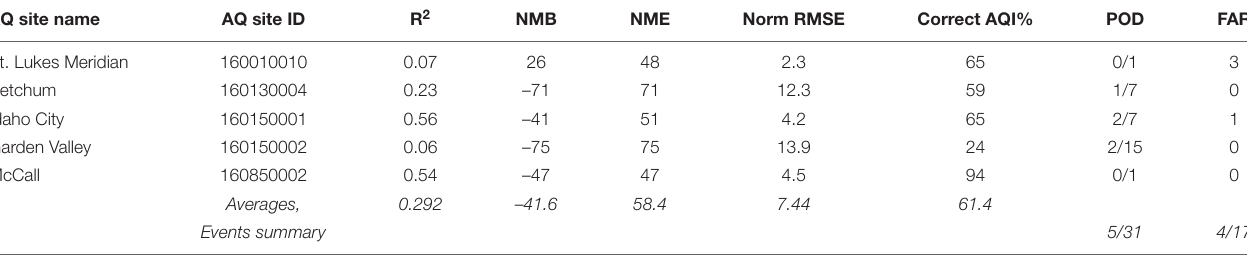
TABLE 7 | Performance statistics for AIRPACT5 CMAQ simulation 24-h PM 2 . 5 at AQ-monitoring sites for the 2016 Pioneer